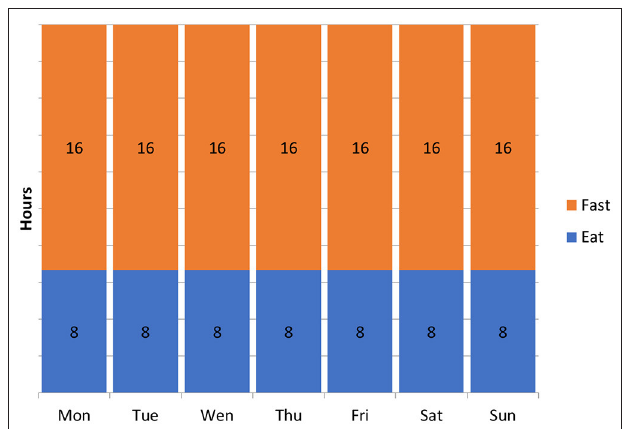
FIGURE 4 | Hourly fasting